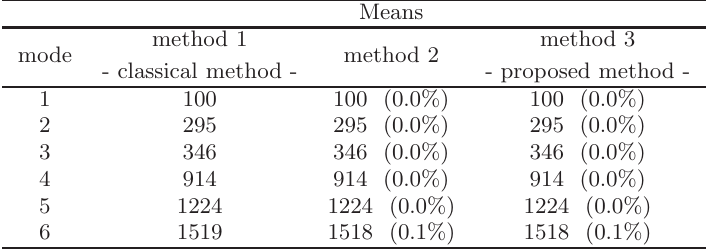
Table 3. The Means of the six first natural frequencies of the propeller ( and the relative errors ) (Hz).